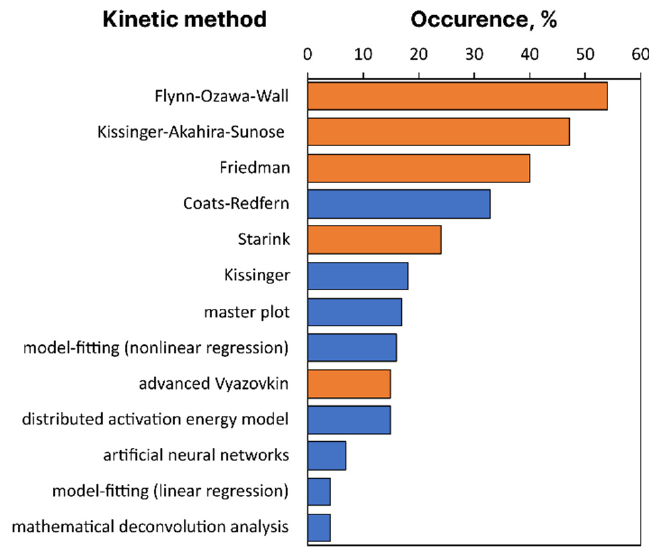
Figure 5. Occurrence of kinetic methods in top 100 most cited thermokinetic studies from 2021. Bars for isoconversional methods are filled as orange. Only methods appeared in more than 4% of ana ‐ lyzed papers are shown.